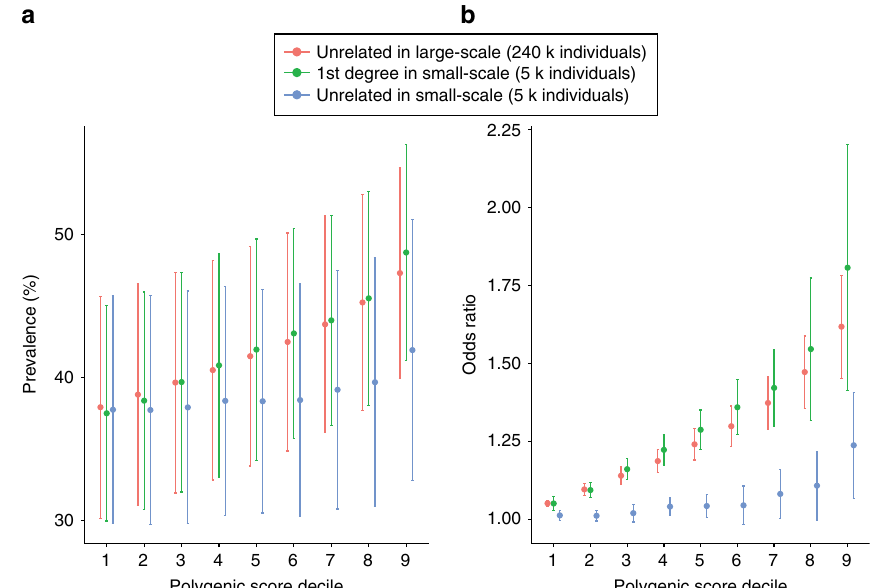
Fig. 6 Clinical impact of polygenic risk scores when using dichotomous traits. Prevalence of cases ( a ) and odds ratio ( b ) in decile analyses of polygenic risk scores for 12 dichotomous traits are shown. For each trait, the target individuals were divided into ten deciles according to their PRS (1 = lowest and 10 = highest). The prevalence was calculated as the proportion of cases in the target individuals above each decile. The odds ratios were calculated from the odds (case/controls) for the target individuals above each decile that was divided by the odds for the whole UKB individuals (i.e., general population). The dot points and error bars represent the mean value and 95% con fi dence interval over the analyses of 12 binary traits selected from the 50 complex traits (Supplementary Table 1). The prevalence in the top PRS above the 1st – 9th decile of PRS varied and increased on average from 37.9% to 47.3% in the analysis with unrelated individuals in the large-scale design. Similarly, in the analysis with fi rst-degree relatives in the small- scale design, the prevalence increased from 38% to 48.1%. lated individuals from the small-scale design was low (a pre- valence of 41.9% even for the top 10% PRS) (Fig. 6a). The ratio of